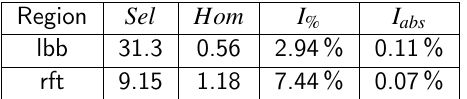
Tab.1: Numerical results of the evaluation for the regions left, back, bottom (lbb) and right, front, top (rft). The respective electrode positions are shown in Fig. 2